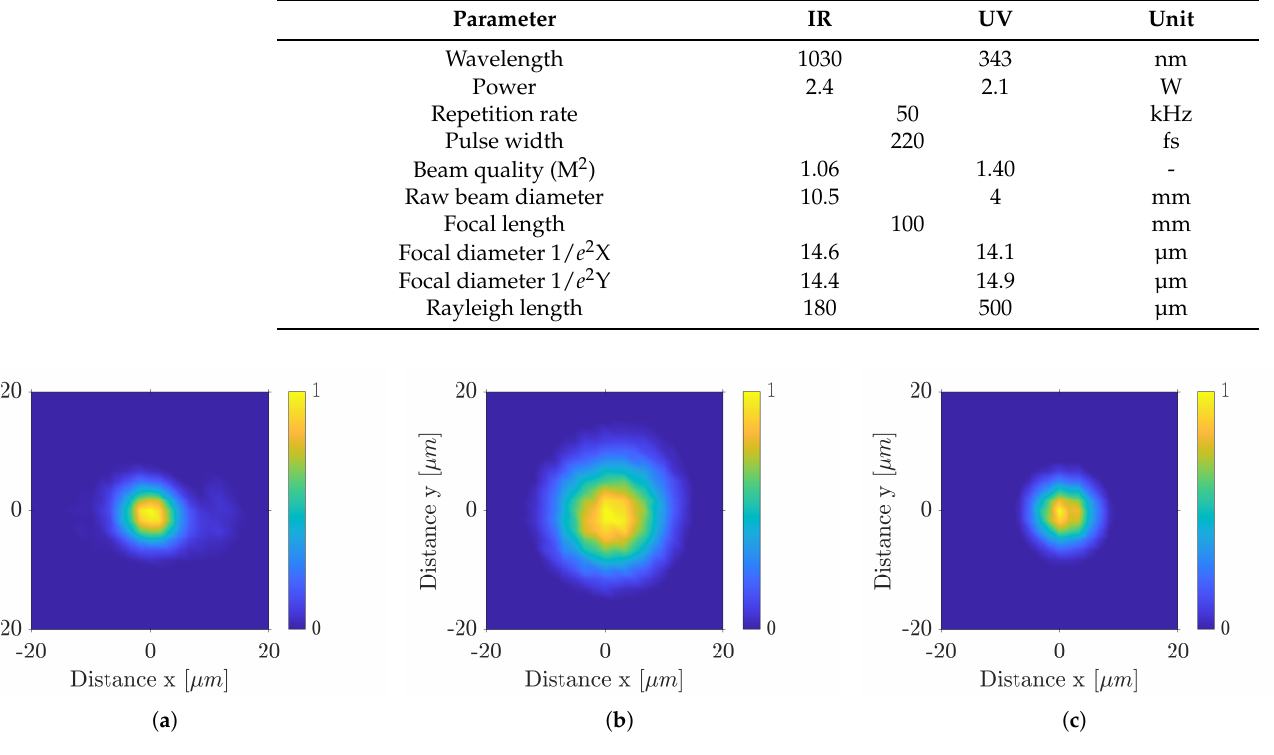
Figure 2. Focal points of the wavelength in ( a ) UV Z = 0mm ( b ) UV defocused (Z = − 1mm) ( c ) IR with BET (Z =